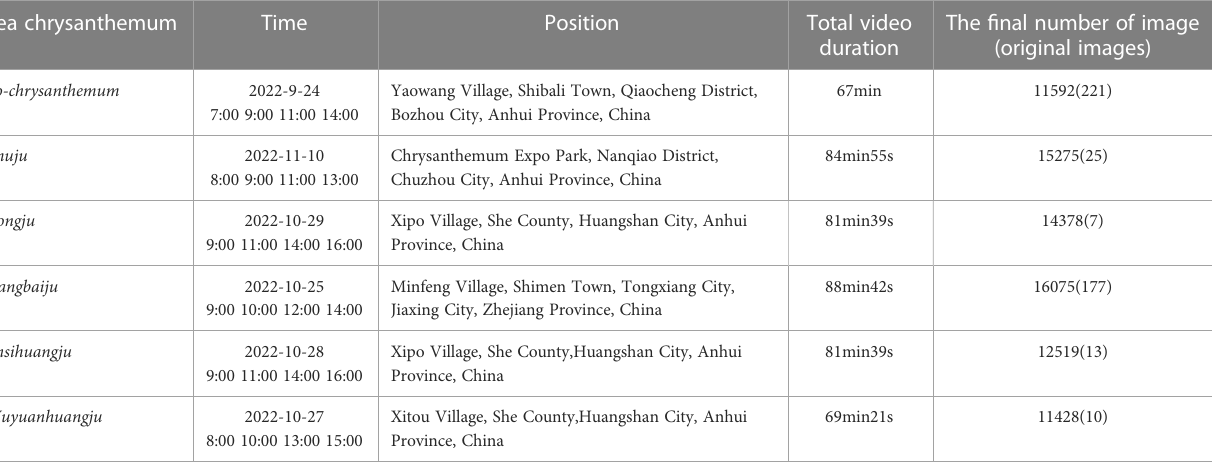
TABLE 1 Collection details about tea chrysanthemum dataset.